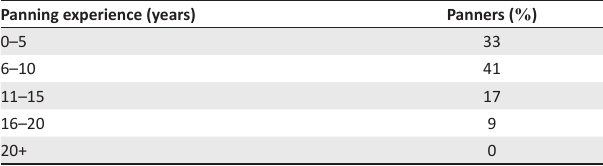
TABLE 3: Panners’ experience.